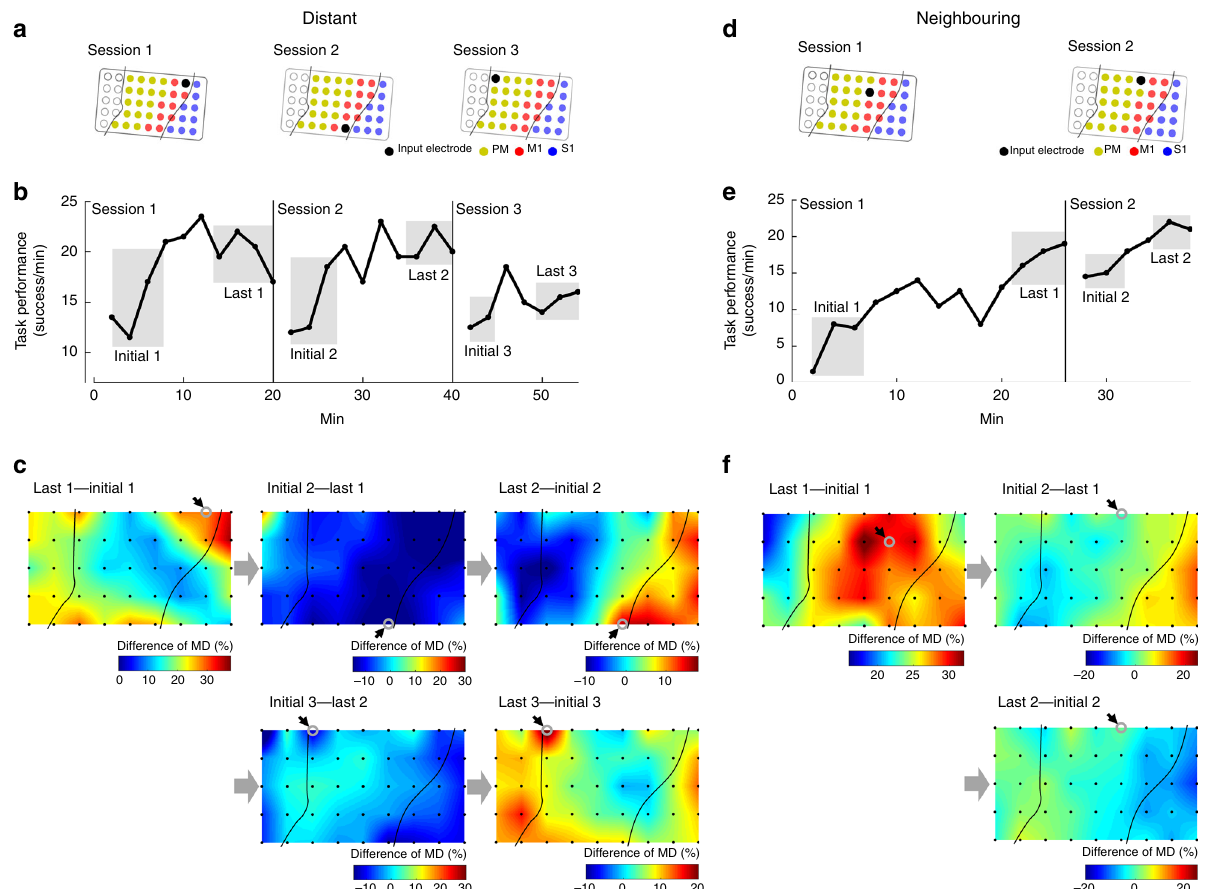
Fig. 6 The ACMC induces fl exible cortical adaptation. a – c Three successive sessions using different electrodes in anatomically distant areas. a The ACMC input electrode is represented by a black fi lled circle in each session. The somatotopy of each electrode was evaluated when the monkey was intact. The electrode in M1 was placed in the shoulder area in Session 1, in the digit area in Session 2, and in the shoulder area in Session 3. Electrical stimuli were applied to the FCR muscle in Session 1, the ECR and EDC muscles in Session 2, and the ECU muscle in Session 3. Data were obtained from Monkey M. b Time course of task performance in three subsequent ACMC sessions with different input electrodes. The MDs of high-gamma activity were calculated from data obtained during the initial and last phases in each session, indicated in grey. c The spatial distribution of MD changes were compared between the initial and last phases in each session (i.e. Last 1 – Initial 1, Initial 2 – Last 1, Last 2 – Initial 2, Initial 3 – Last 2 and Last 3 – Initial 3). The grey open circles with black arrows represent the input electrode. d – f Two successive sessions using electrodes in nearby areas. d The ACMC input electrode, shown as a black fi lled circle, was in the vicinity of the PM in consecutive sessions. Electrical stimuli were applied to the FCR muscle in Session 1 and the FCU muscle in Session 2. Data were obtained from Monkey M. e Time course of task performance in two consecutive sessions with the input electrode in neighbouring sites. MDs were measured during the grey-shaded initial and last phases of each session. f Changes in the spatial distribution of MD were compared between the initial and last phases in each session (i.e. Last 1 – Initial 1, Initial 2 – Last 1, and Last 2 – Initial 2). Grey un fi lled circles with black